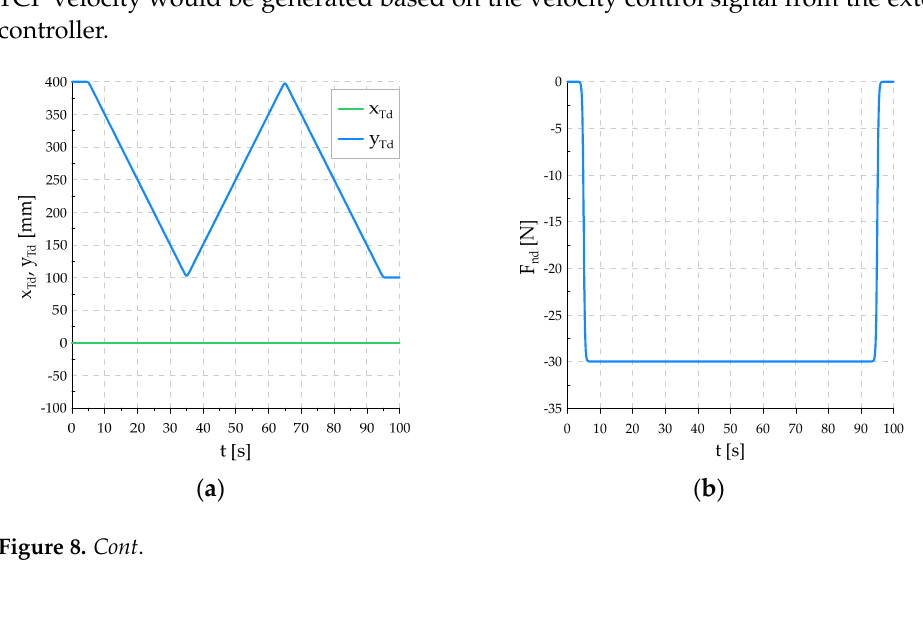
Table 3. Control system parameters.